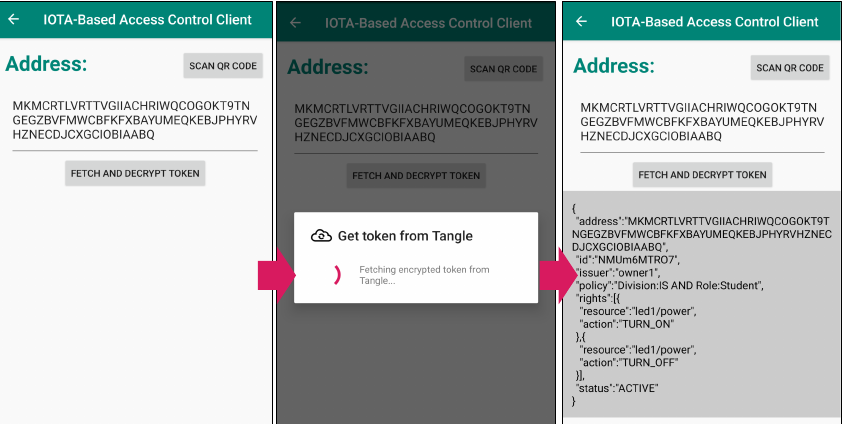
Figure 11. Token fetching from Tangle and decryption.